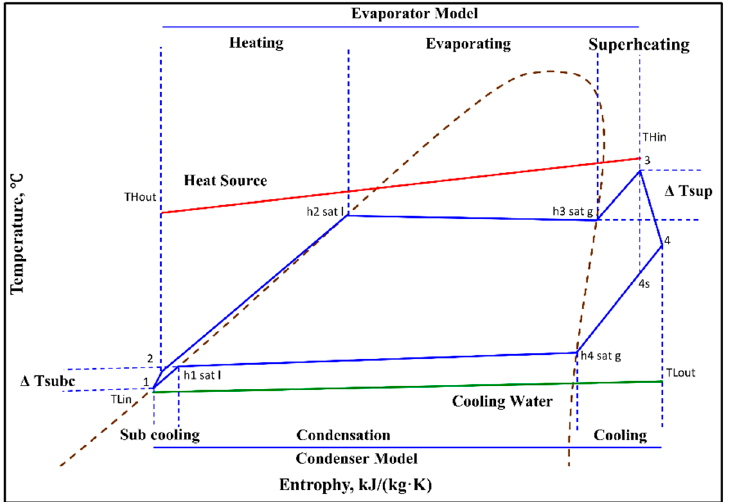
Figure 2. The principle operation and heat transfer of the Organic Rankine Cycle (ORC) system.